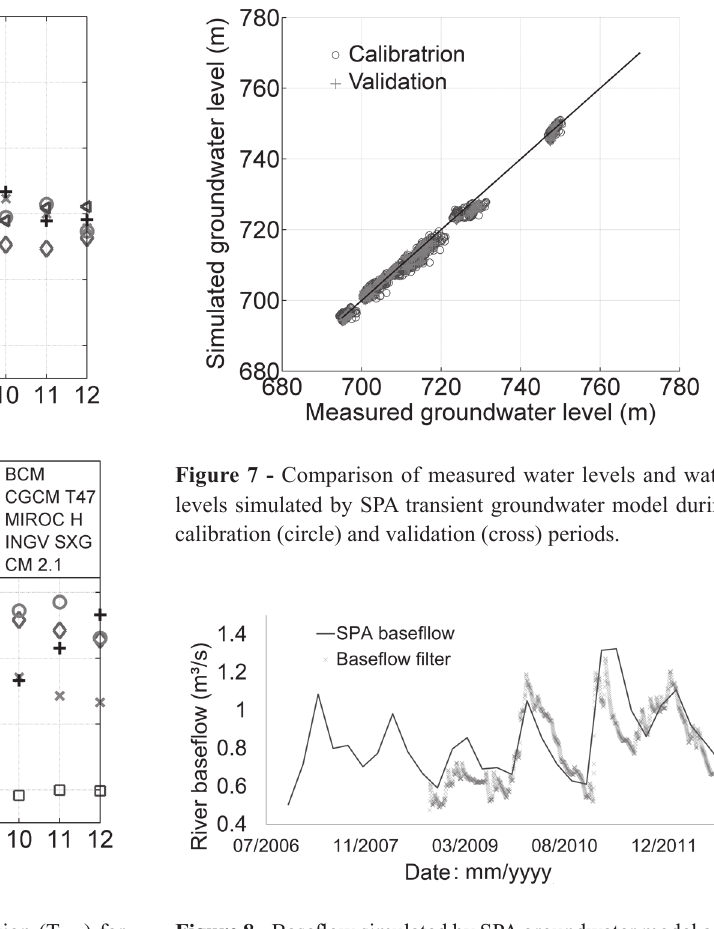
Figure 6 - Monthly mean changes in precipitation (T the 10 future scenarios (2081-2099) divided by the observed precipitation (T ) during the control period (1971-1999). obs